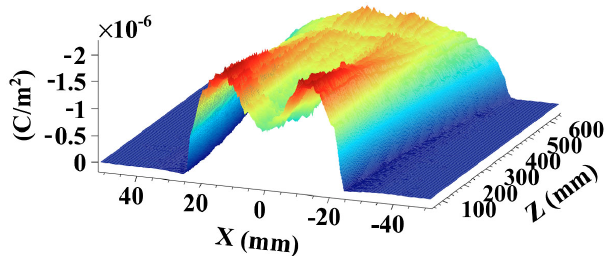
FIG. 7. Total space charge density (beam and secondary ions) during the SCC buildup. t ¼ 0 . 4 τ